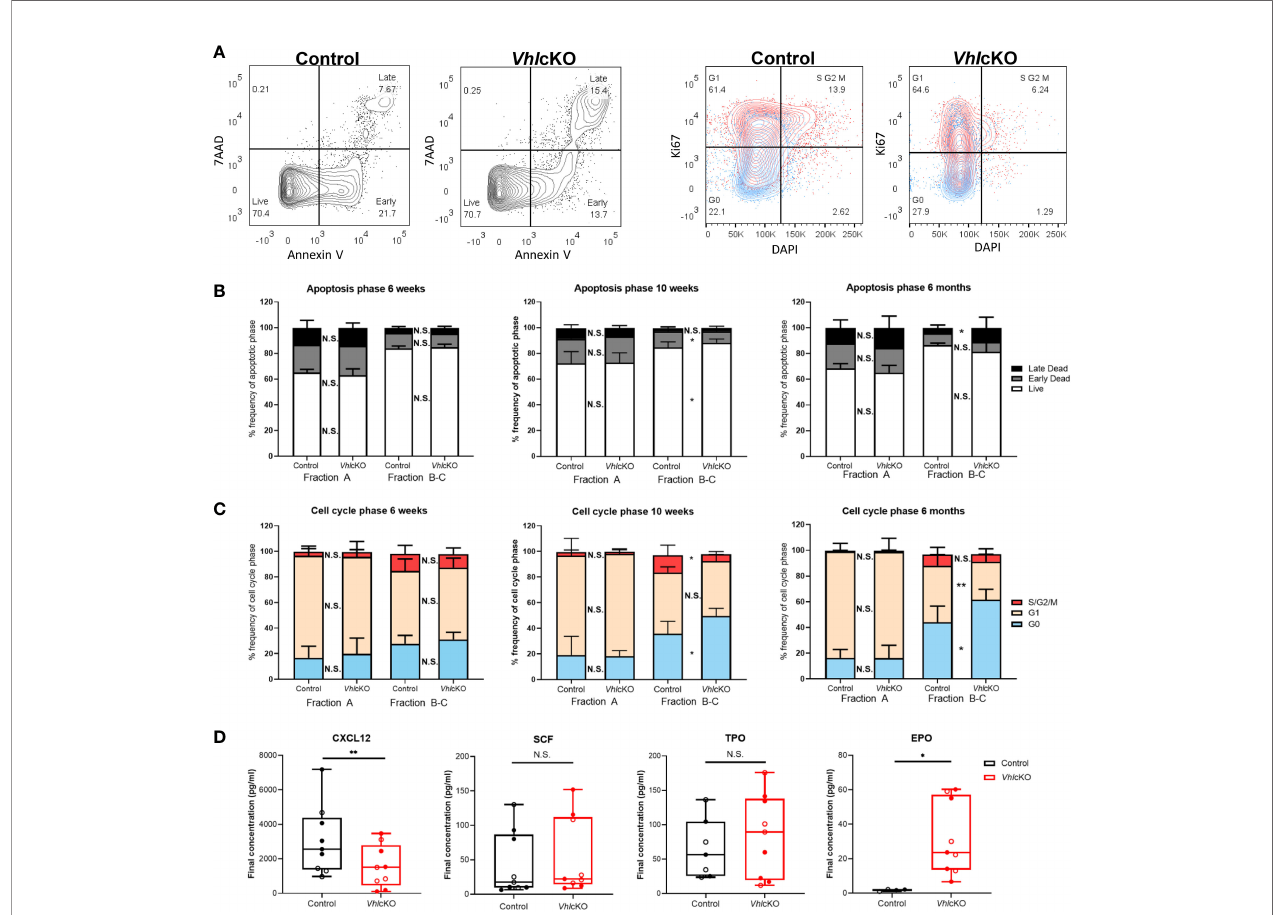
FIGURE 5 | Vhl cKO mice display increase apoptosis and reduced cell proliferation during early B cell development. (A) Representative FACS plots of apoptotic phases (live, early apoptosis, and late apoptosis) in B220+ cells (left) and cell cycle phases (G0 (quiescent), G1, and S/G2/M) in B220+ cells (red:CD43+ blue: CD43-) (right) in 10-weeks-old mice; (B) frequency of apoptotic phases in Fractions A and B-C in 6-weeks-old, 10-weeks-old and 6-month-old mice; (C) frequency of cells in each cell cycle phase within Fractions A and B-C at 6-weeks-old, 10-weeks-old old and 6-month-old mice. Our cell cycle analysis antibody panel ( Supplementary Table 1 ) did not include anti-IgM and anti-IgD, so we could not remove these cells from the CD43+ population. However, these cells are very low in frequency in the Vhl cKO ( Figure 3 ) and do not signi fi cantly change the proliferation results in controls (data not shown); (D) CXCL12, SCF, TPO, and EPO cytokine level measurements in bone marrow supernatant of combined 10-weeks-old ( fi lled) and 6-months-old (open) control or Vhl cKO mice. p<0.05*, p<0.01** two-tailed Student ’ s t-test. N.S., not statistically signi fi